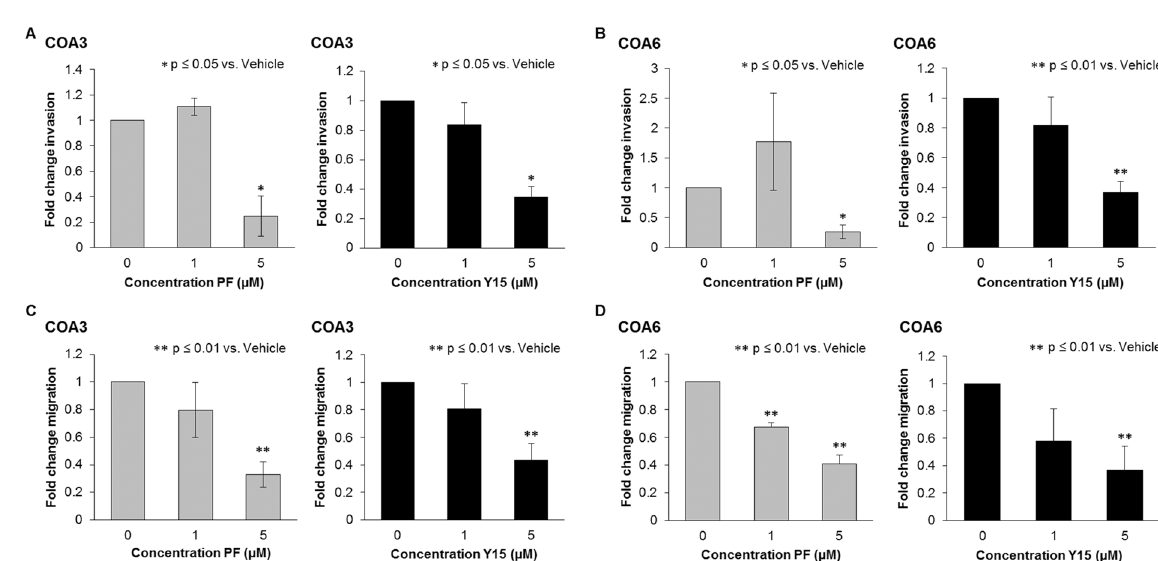
Figure 4. FAK inhibition decreased invasion and migration of COA3 and COA6 PDX cells. ( A ) COA3 cells (3 × 10 6 ) were treated for 24 hours with increasing concentrations of PF (0, 1, 5 μ M) and Y15 (0, 1, 5 μ M) and plated in Transwell plates. Cells were allowed to invade for one week through a Matrigel layer. Treatment with both PF and Y15 resulted in a statistically significant decrease in COA3 cell invasion. ( B ) COA6 cells (4 × 10 4 ) were treated for 24 hours with increasing concentrations of PF and Y15 and plated in Transwell plates. Cells were allowed to invade for one week through a Matrigel layer. Treatment with both PF and Y15 resulted in a statistically significant decrease in COA6 cell invasion. ( C ) COA3 cells (3 × 10 6 ) were treated with increasing concentrations of PF (0, 1, 5 μ M) and Y15 (0, 1, 5 μ M) for 24 hours, plated into Transwell migration plates, and allowed to migrate for 72 hours. Treatment with both PF and Y15 resulted in a statistically significant decrease in COA3 cell migration. ( D ) COA6 cells (4 × 10 4 ) were treated for 24 hours, plated into Transwell migration plates and allowed to migrate for 72 hours. Treatment with both PF and Y15 resulted in a statistically significant decrease in COA6 cell migration. Data represent at least three biologic replicates and are reported as mean ±